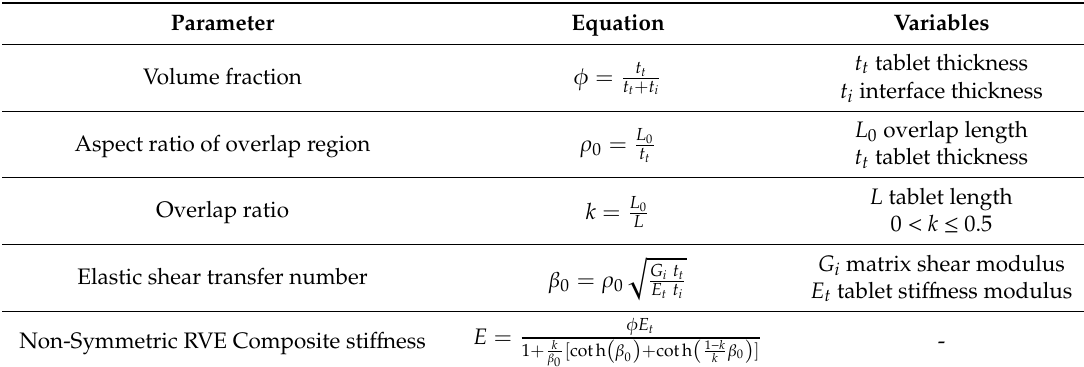
Table 2. Shear lag model equations and